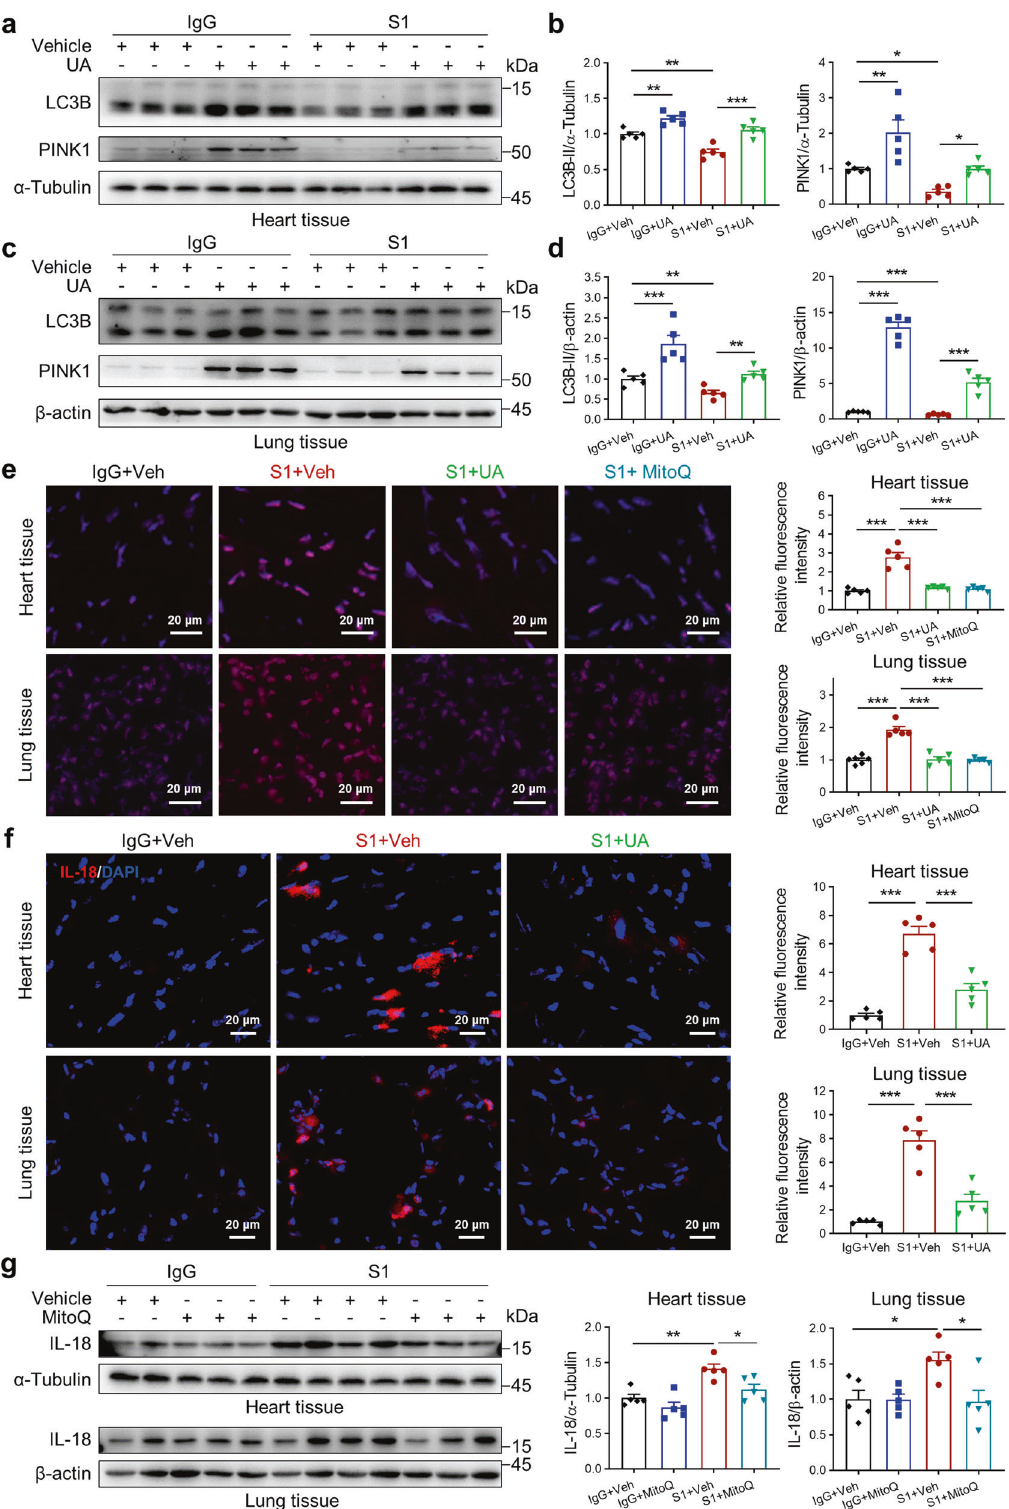
Fig. 6 Spike protein induces IL-18 expression via reduced mitophagy and increased mitoROS production in vivo. Western blots ( a ) and quantitative data ( b ) of LC3B and PINK1 levels in heart tissues from IgG- versus S1 protein-treated mice with UA treatment (1-way ANOVA test, N = 5). Western blots ( c ) and quantitative data ( d ) of LC3B and PINK1 levels in lung tissues from IgG- versus S1 protein-treated mice with UA treatment (1-way ANOVA test, N = 5). e Representative DHE staining images and quantitative data of heart and lung from IgG- versus S1 protein-treated mice with UA or MitoQ treatment (1-way ANOVA test, N = 5). Scale bar, 20 μ m. f Representative immuno fl uorescence images and quantitative data showing stained IL-18 in heart and lung tissue from IgG- versus S1 protein-treated mice with UA treatment (1-way ANOVA test, N = 5). Nuclei counterstained with DAPI. Scale bar, 20 μ m. g Western blots and quantitative data of IL-18 levels in heart and lung tissues from IgG- versus S1 protein-treated mice with MitoQ treatment (1-way ANOVA test, N = 5). Values are mean ± SE. * p < 0.05, ** p <0.01, *** p <0.001 Signal Transduction and Targeted Therapy (2023)